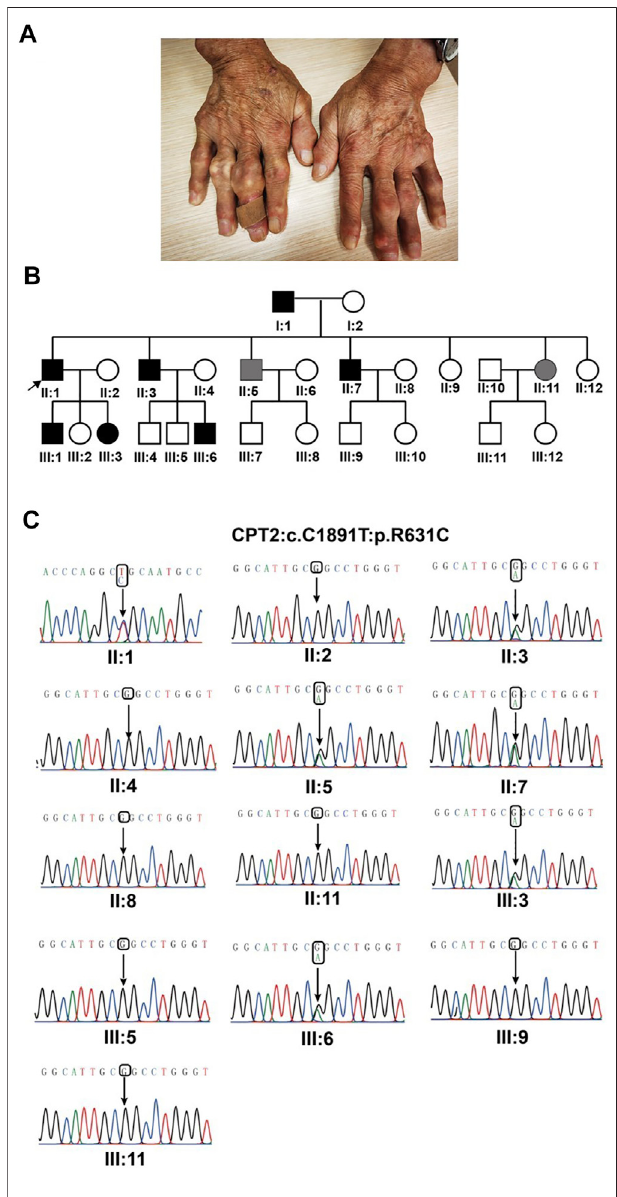
FIGURE 1 | Identi fi cation of CPT2 missense in the gout family. (A) . Representative photographs of the proband in gout family reveal multiple tophi, indicating long disease duration and a severe disease burden. (B) . Pedigree and co-segregation results. Affected individual is represented as a fi lled square. Normal individuals are shown as empty symbols. (C) . Sanger sequencing con fi rmed the segregation of the rare missense variant, c.1891C > T,